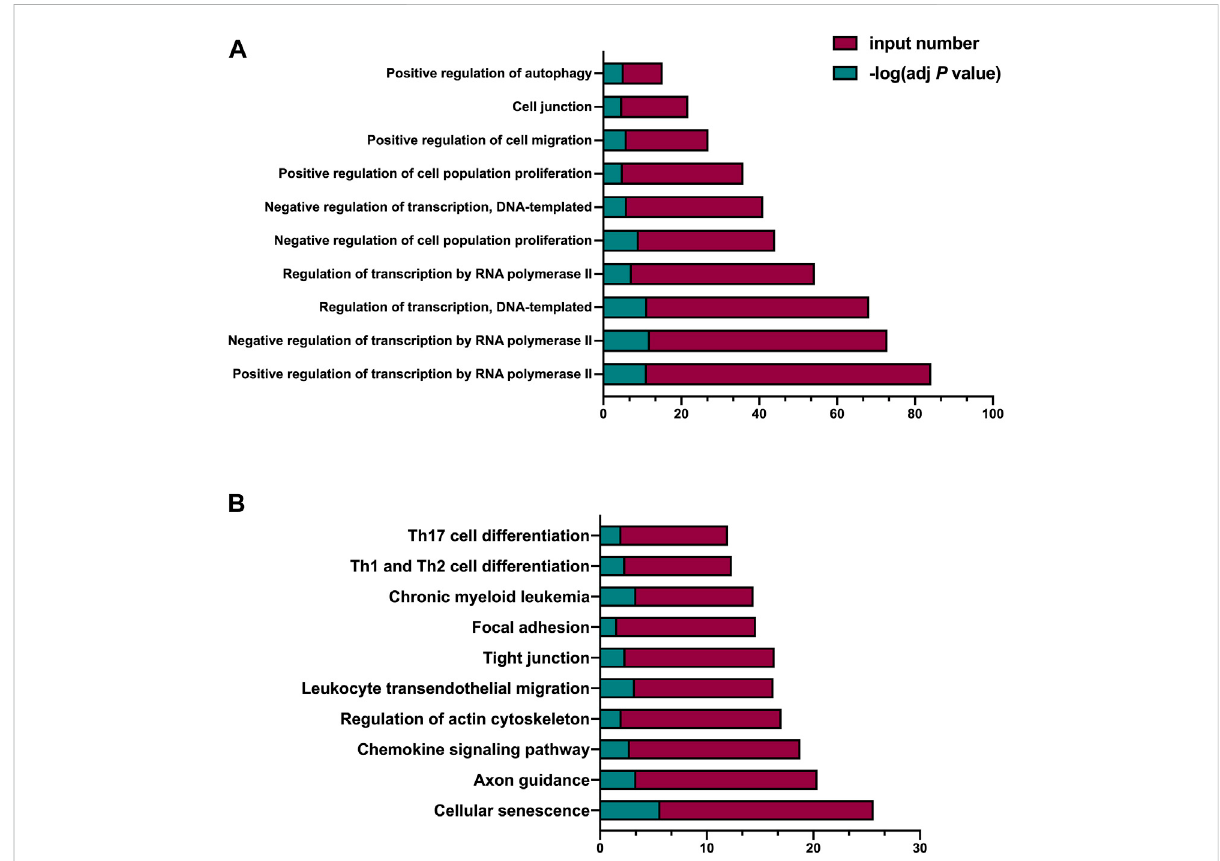
FIGURE 2 Bioinformatic analysis of the miRNA-23a, miRNA-99a, and lncRNA H19 in the noncoding RNA score. (A) GO analysis of the variables in the noncoding RNA score. (B) KEGG analysis of the variables in the noncoding RNA score. adj p value indicated the FDR-adjusted p value; input number indicated the number of enriched targeted mRNAs; GO, Gene Ontology; KEGG, Kyoto Encyclopedia of Genes and